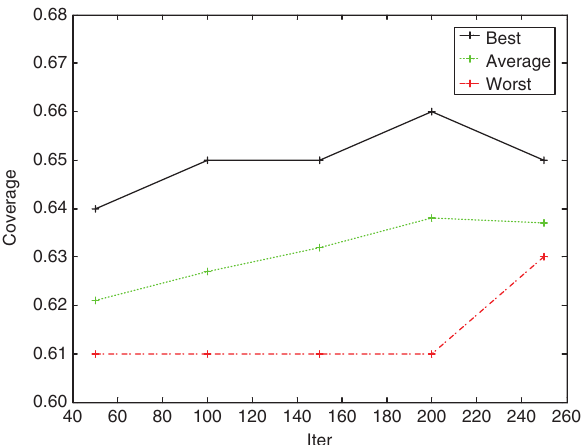
Figure 6: Three Kinds of the Line Charts of the Coverage Rate with the Iteration Number Changing.